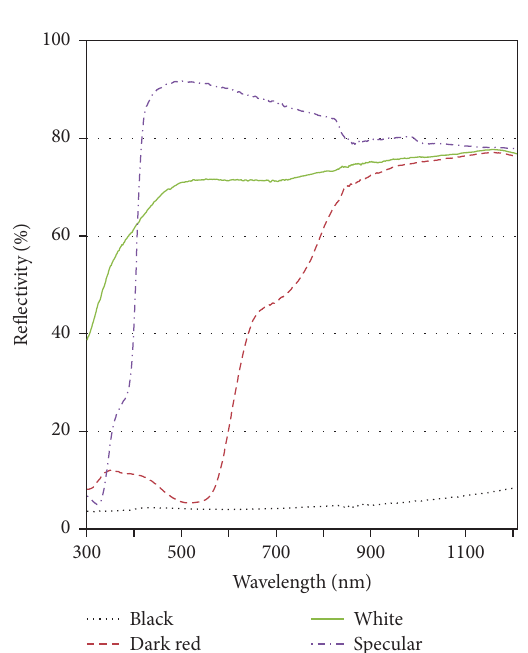
Figure 3: Reflectivity by reflector type. Table 2: Rated electrical specifications of the bifacial cell. Front Rear